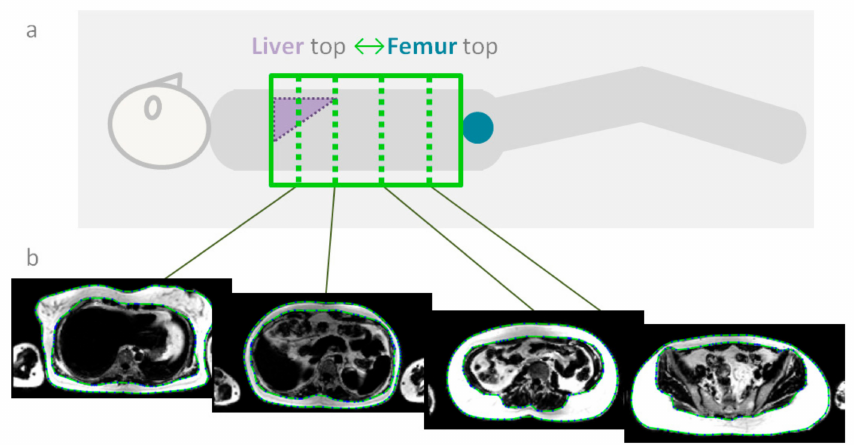
Figure 1. ( a ) Symbolic view of the definition of the abdominal magnetic resonance imaging (MRI) imaging volume (green box) between the top of the femoral heads (blue circle) and the liver (purple triangle) apex. ( b ) Corresponding MRI slices at four in ( a ) marked exemplary positions within the imaging volume. The dashed green lines within the MR-images show the segmentation borders of subcutaneous fat volume. Reconstructed images are based on the fat-water Dixon MR-images acquired with a spoiled gradient echo sequence (repetition time TR = 171 ms, four echo times TE = {1.11,